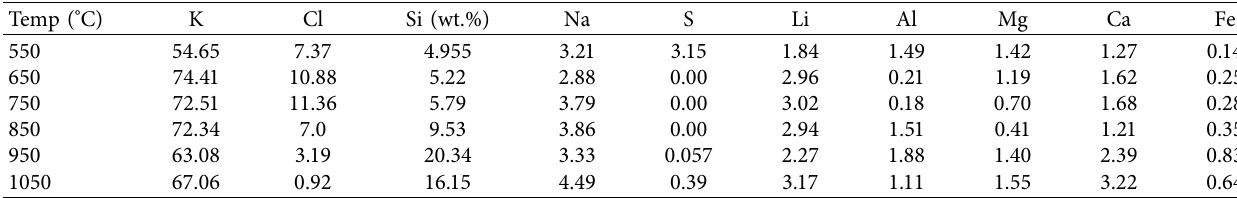
Figure 4: XRD pattern of (a) calcined banana ash blends, (b) burnt banana ash blends, and (c) fresh banana ash blends. Table 1: Elemental composition of CBA blends.